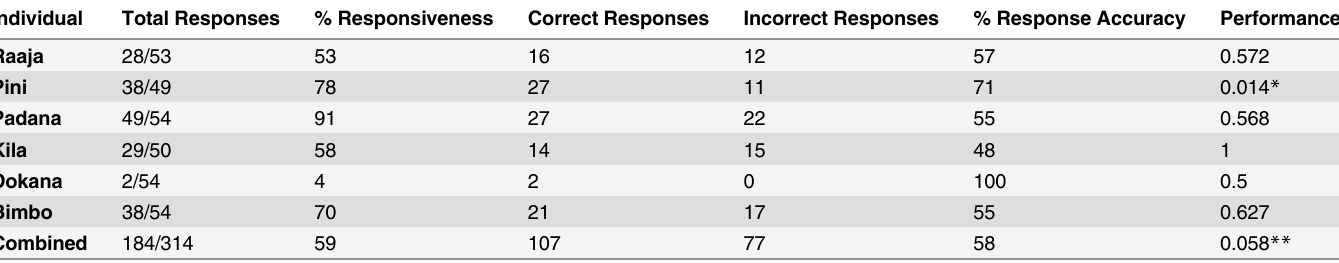
Table 2. Study 2: Individuals ’ Responsiveness to and Comprehension of E1 ’ s